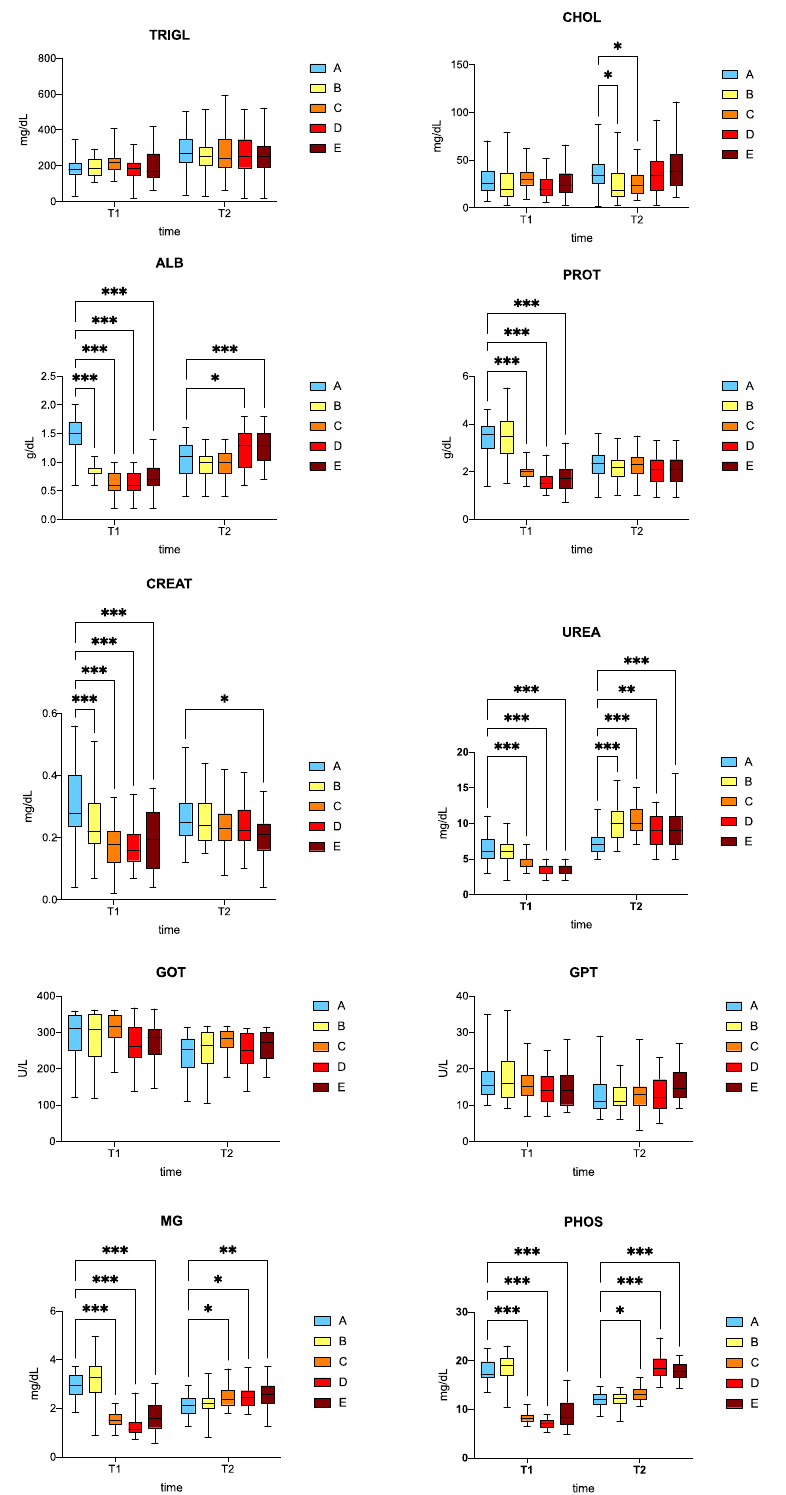
Figure 1. Boxplots of blood biochemical parameters in the serum of rainbow trout ( Oncorhynchus mykiss ). Asterisks indicate significant differences according to Dunnett’s multiple comparison test (* p ≤ 0.05; ** p ≤ 0.01; *** p ≤ 0.001). A: control, B: 0.5%, C: 1%, D: 2%, E: 3% w / w F1-BEO; T1—15 days; T2—30 days. ALB denotes albumin; CHOL cholesterol; CREA creatinine; GOT glutamic oxaloacetic transaminase; GPT glutamic pyruvic transaminase; MG magnesium; PHOS phosphorus; PROT total proteins; TRIGL triglycerides; UREA